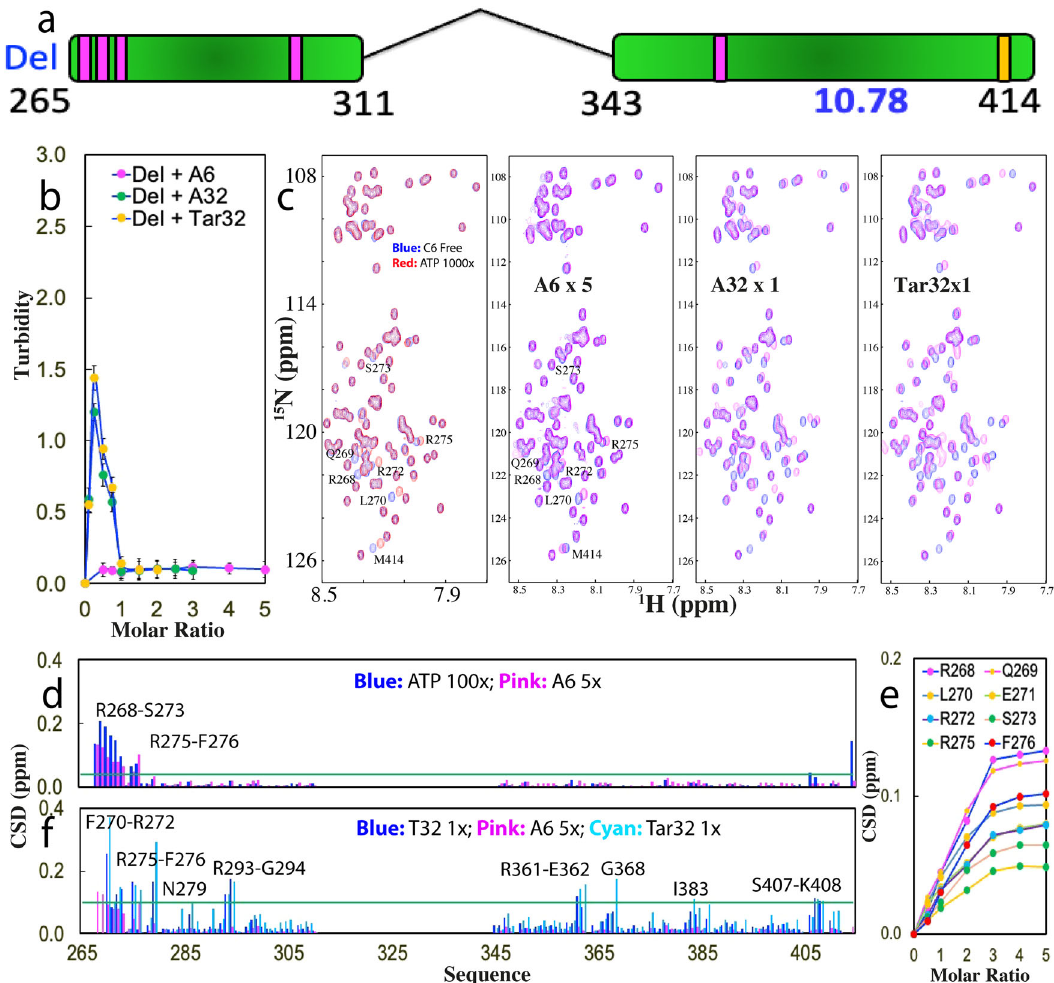
Fig. 3 The hydrophobic region is not essential for LLPS driven by ssDNA. a Schematic representation of TDP-43 Del-PLD with residues 311-343 deleted. b Turbidity curves of Del-PLD in the presence of Tar32, A6 and A32 at different molar ratios. c HSQC spectra of Del-PLD in the absence (blue) and in the presence of ATP at a molar ratio of 1:1000 (red), as well as A6 at 1:5, A32 and Tar32 at 1:1 (purple). d Chemical shift difference (CSD) of Del-PLD between the free state and in the presence of ATP at 1:1000 (blue) and A6 at 1:5 (purple) respectively. The green line is used to indicate the value (0.04): Average + STD at the ratio of 1:5 (Del-PLD:A6). The residues with CSD values > Average + SD are de fi ned as signi fi cantly perturbed residues and labeled. e CSD tracings of eight signi fi cantly perturbed residues in the presence of A6 at different ratios. f Chemical shift difference (CSD) of Del-PLD between the free state and in the presence A6 at 1:5 (purple), A32 at 1:1 (blue) and Tar32 at 1:1 (cyan) respectively. The green line is used to indicate the value (0.1): Average + STD in the presence Tar32 at the ratio of 1:1 (Del-PLD:Tar32). The residues with CSD values > Average + SD are de fi ned as signi fi cantly perturbed residues and